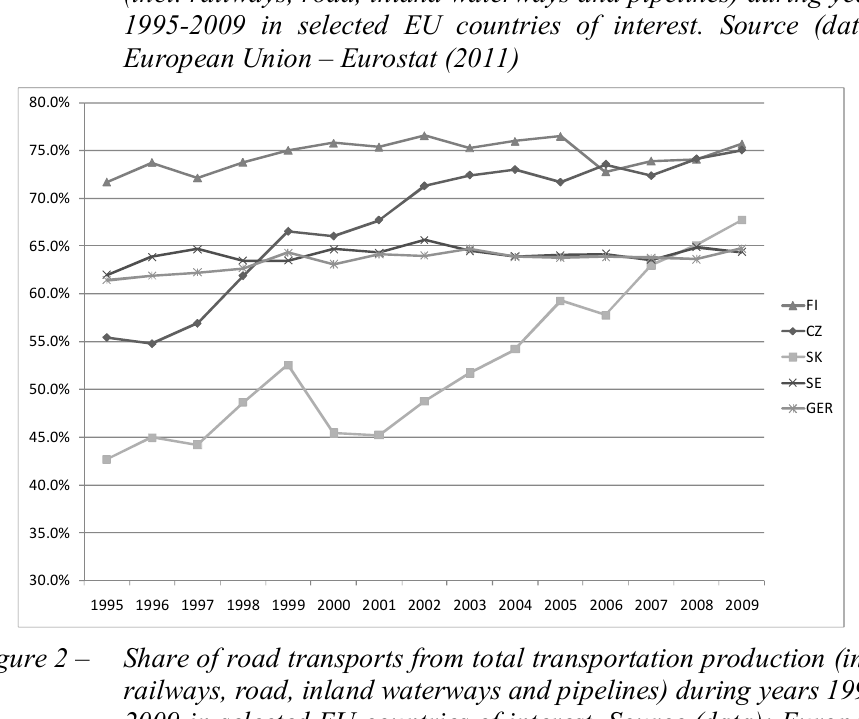
Figure 2 – Share of road transports from total transportation production (incl. railways, road, inland waterways and pipelines) during years 1995- 2009 in selected EU countries of interest. Source (data): European Union – Eurostat